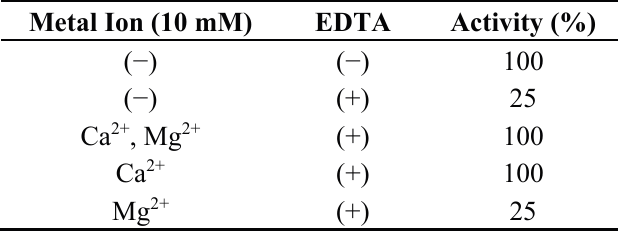
Figure 4. Effect of temperature and pH on the hemagglutination activity of Apios tuber lectin (ATL). ( A ) ATL was incubated at the indicated temperatures for 30 min; ( B ) ATL was incubated at various pH values overnight. After adjusting the pH to 7, the hemagglutination activity was measured. Solid line: ATL, broken line: Soybean lectin (SBA). Table 2. Requirement of divalent metal ions for hemagglutination activity. The activity recovered was indicated when the non-treated activity was